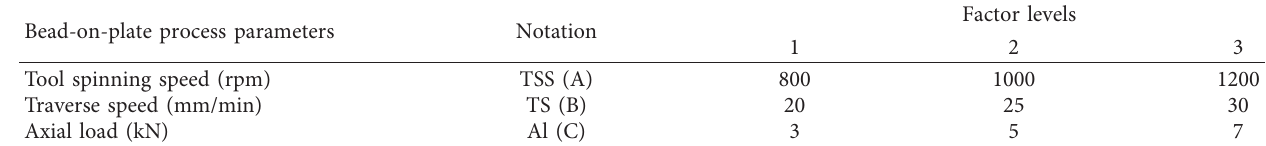
Table 2: FSP parameters and factor levels.